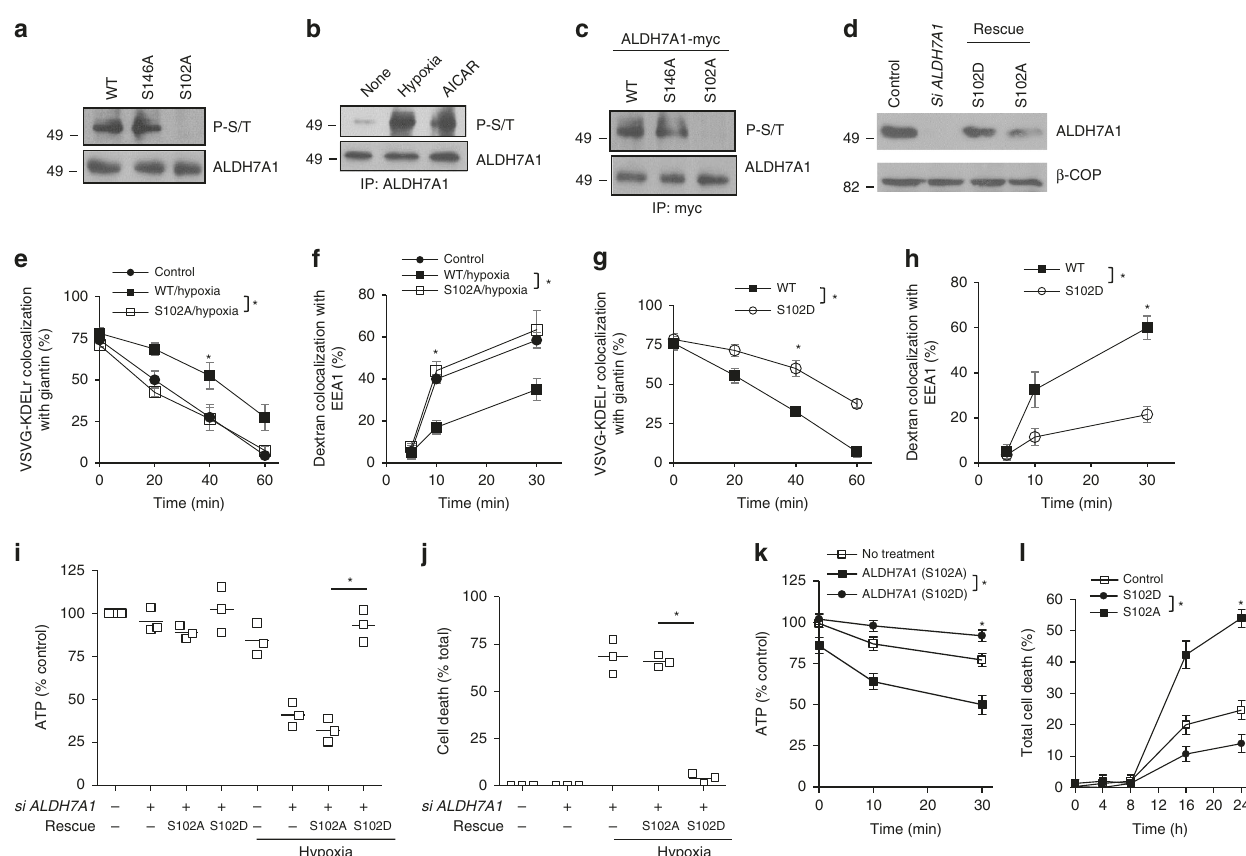
Fig. 9 AMPK phosphorylates ALDH7A1. Quantitative results are shown as mean with standard deviation; * p < 0.05, NS not signi fi cant, paired two-tailed Student ’ s t -test. Source data are provided as a Source Data fi le. a The in vitro kinase assay was performed, followed by immunoblotting for phospho-AMPK substrate (upper panel) or ALDH7A1 (lower panel); n = 2 independent experiments with a representative result shown. b HeLa cells were treated as indicated. ALDH7A1 was then immunoprecipitated from whole-cell lysates, followed by immunoblotting for phospho-AMPK substrate (upper panel) or ALDH7A1 (lower panel); n = 2 independent experiments with a representative result shown. c HeLa cells were transfected with constructs as indicated. Cells were than subjected to hypoxia, followed by immunoprecipitation of ALDH7A1 and then immunoblotting for ALDH7A1 or the phospho-AMPK substrate antibody; n = 2 independent experiments with a representative result shown. d Immunoblotting of whole-cell lysates showing ef fi cacy of siRNA against ALDH7A1 , and the level of ALDH7A1 mutants expressed for rescue studies; n = 2 independent experiments with a representative result shown. e COPI transport from the Golgi to the ER in HeLa cells was assessed through the quantitative colocalization of VSVG-KDELR with a cis -Golgi marker (giantin); n = 3 independent experiments. f Fluid-phase endocytosis of dextran in HeLa cells was assessed through the quantitative colocalization of internalized dextran with an early endosome marker (EEA1); n = 3 independent experiments. g COPI transport from the Golgi to the ER in HeLa cells was assessed through the quantitative colocalization of VSVG-KDELR with a cis -Golgi marker (giantin); n = 3 independent experiments. h Fluid-phase endocytosis of dextran in HeLa cells was assessed through the quantitative colocalization of internalized dextran with an early endosome marker (EEA1); n q = 3 independent experiments. i HeLa cells were treated as indicated, and then total ATP level was quanti fi ed; n = 3 independent experiments. j HeLa cells were treated as indicated, and then cell death was quanti fi ed; n = 3 independent experiments. k HeLa cells were treated with starvation conditions as indicated, and then total ATP level was quanti fi ed; n = 3 independent experiments. l HeLa cells were treated with starvation conditions as indicated,